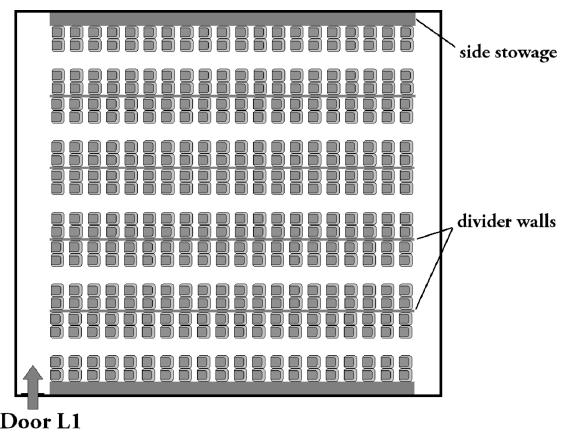
Figure 3. Blended wing body high-density seat layout.